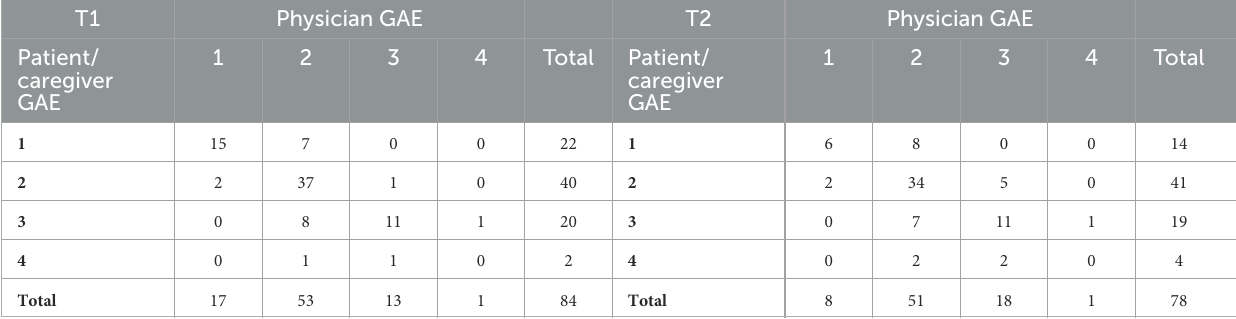
TABLE 6 Correlation between physician- and patient/caregiver-reported efficacy after BoNT-A treatment at T1 and T2. T1 Physician GAE T2 Physician GAE Patient/